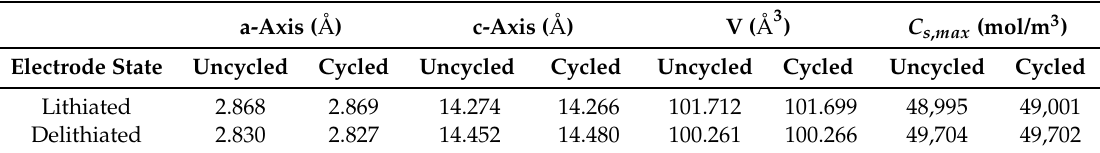
Table 2. Variations of the crystal structure parameters of the NMC electrodes with their lithiation state and ageing.